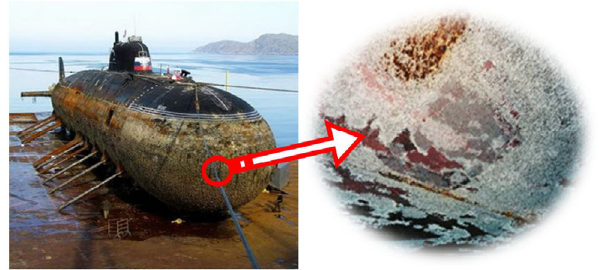
Fig. 10 Fouling and corrosion on the hull surface.